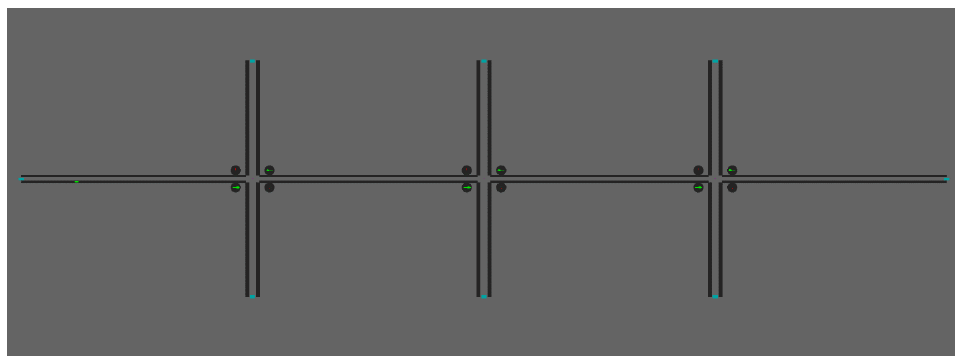
Figure 6. A simulated traffic network with three signalized intersections.